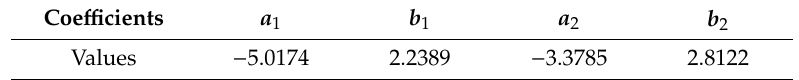
Figure 16. Variation of ( a ) normalized shear stress, ( b ) normalized pressure, and ( c ) ratio of shear stress to pressure with average order parameter S ave for various binary mixtures. The solid volume fraction is ν = 0.5. Table 2. Coefficients in Equations (21) and (22) for binary flows at the solid volume fraction of ν = 0.5.